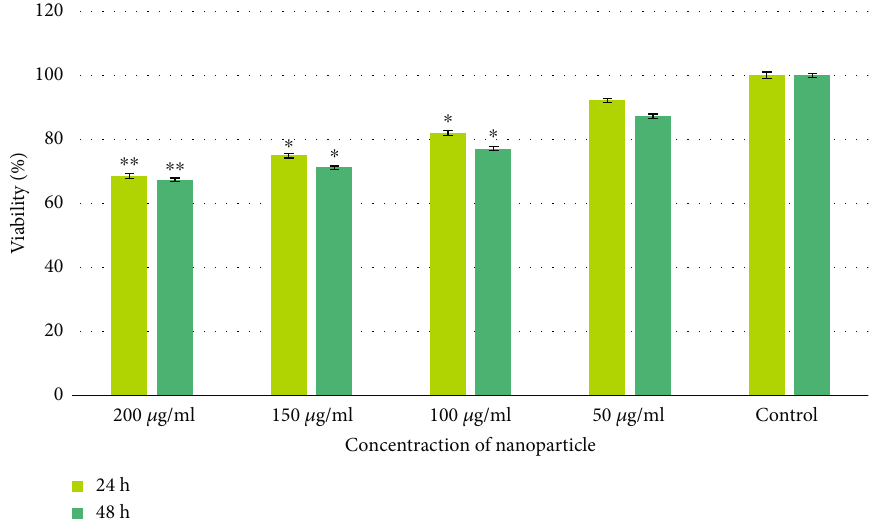
Figure 5: Viability of Caco-2 cells ( ∗ P < 0 : 05 , ∗∗ P < 0 : 01